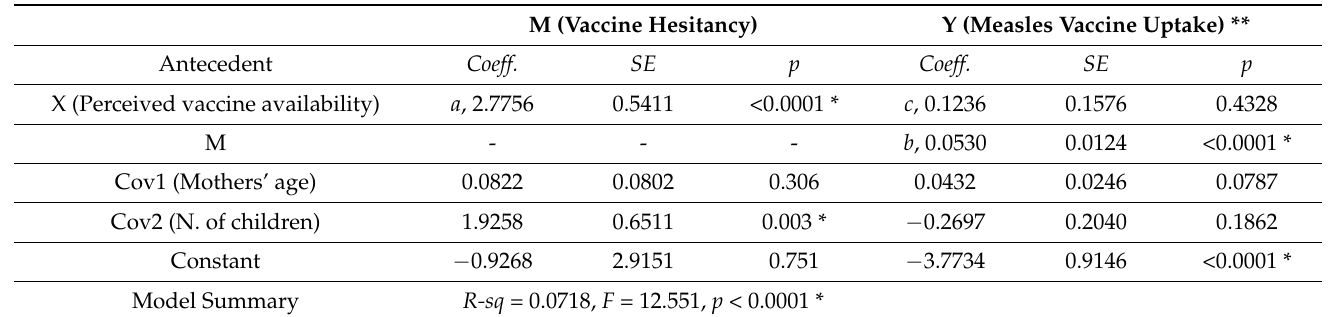
Table 2. Regression coefficients, standard errors, and model summary information for the parental perception about measles vaccine availability using the mediation model depicted in Figure 2. M (Vaccine